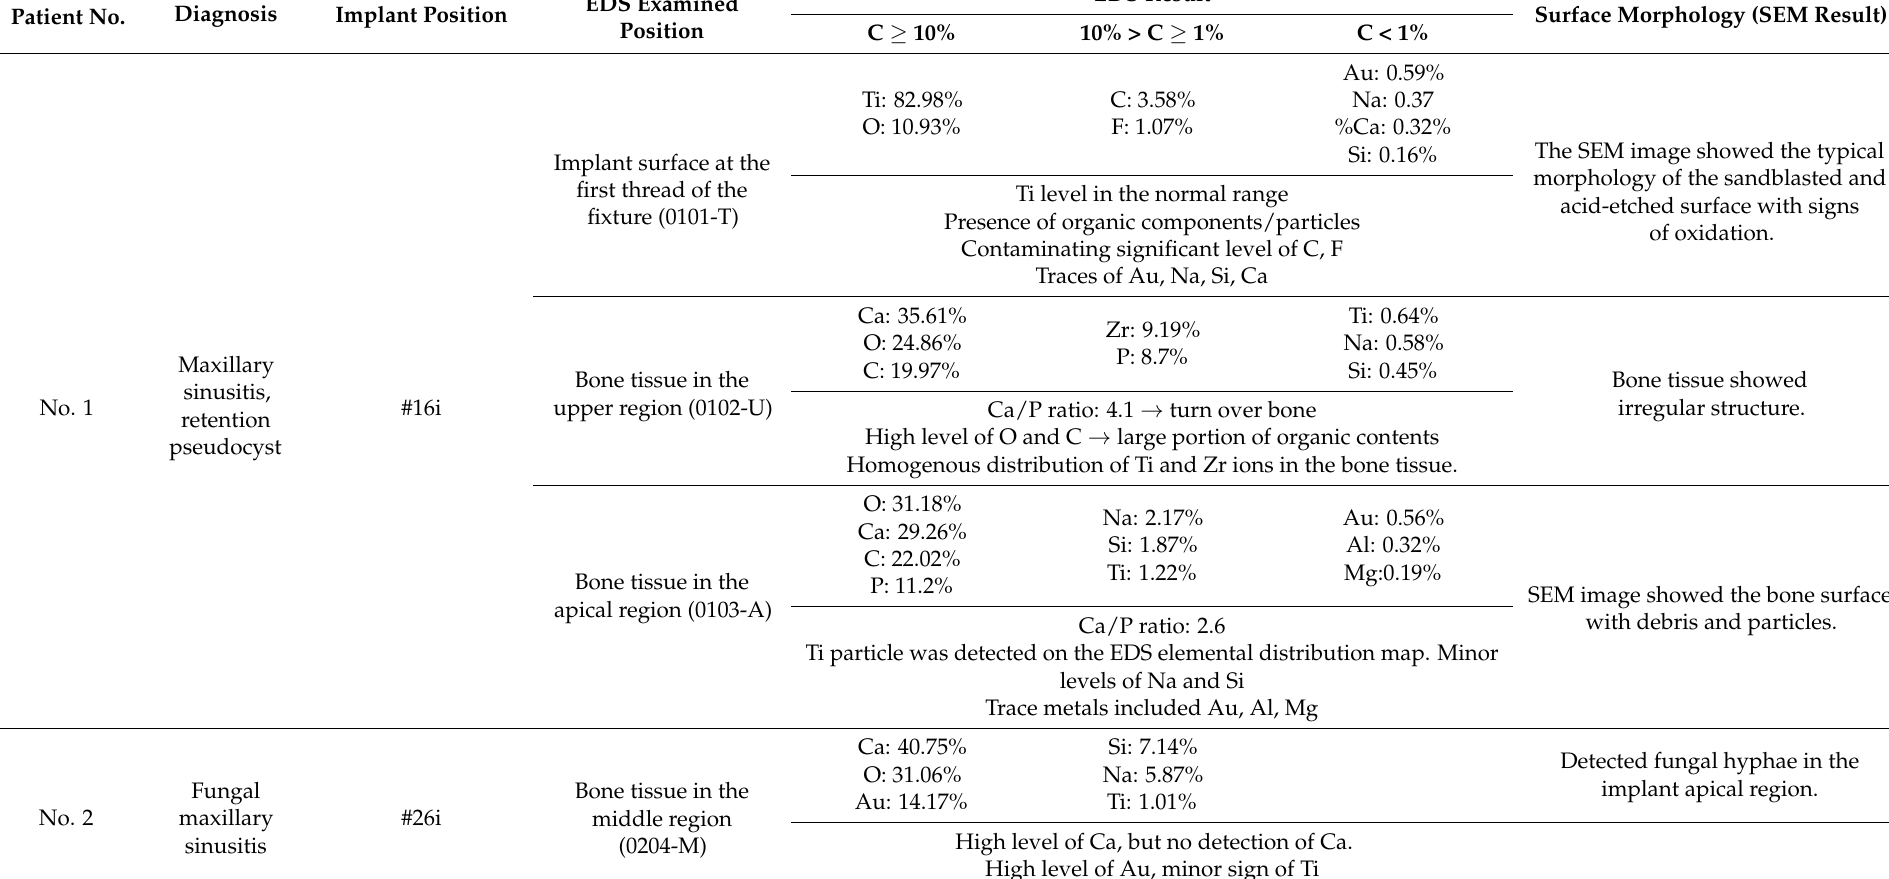
Table 1. EDS data and surface morphology of SEM